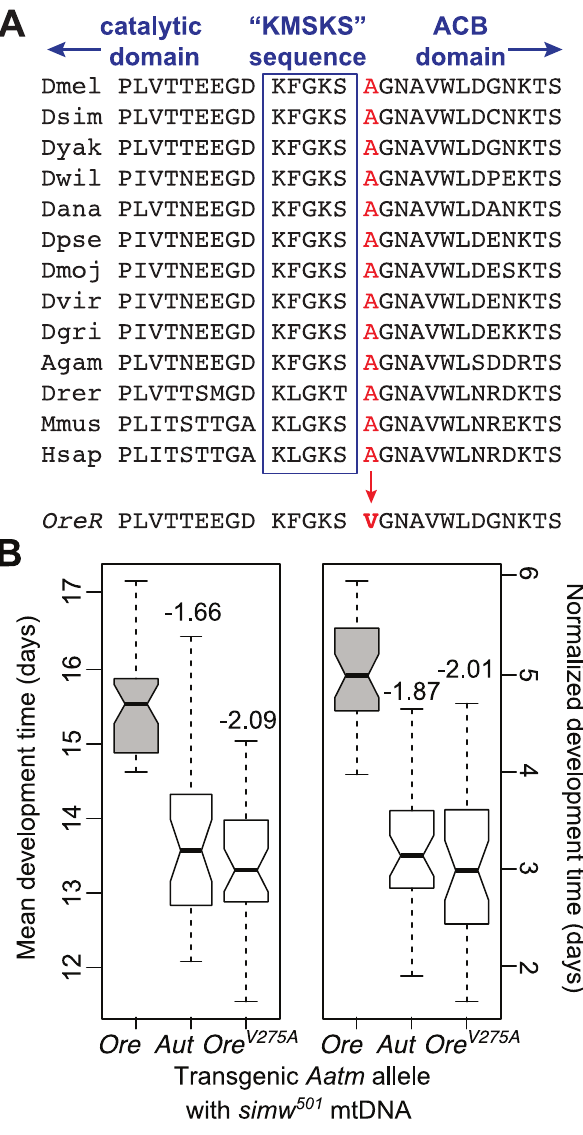
Figure 5. An amino acid change in the mt-TyrRS gene Aatm is incompatible with the mt-tRNA Tyr polymorphism. (A) A nonsy- nonymous SNP in the D. melanogaster OreR nuclear-encoded mt-TyrRS gene Aatm changes a highly conserved alanine to a valine at a residue adjacent to the class I aaRS ‘‘KMSKS’’ signature sequence located in a loop that connects the catalytic domain to the anticodon binding (ACB) domain [38]. Nine Drosophilid species sequences are followed by mosquito ( Anopheles gambiae ), zebrafish ( Danio rerio ), mouse ( Mus musculus ) and human. (B) Both the transgenic Aatm Aut allele and the Aatm Ore_V275A allele that reverts the valine in the OreR allele to the conserved alanine significantly recover development time in a simw 501 mitochondrial background and recapitulate the developmental differ- ence between the ( simw 501 ); OreR and ( simw 501 ); AutW132 genotypes. Boxplots show the distributions of mean development time for all individuals emerging from a single vial, and notches indicate the approximate 95% confidence intervals around the medians. Numbers above the boxes indicate the magnitude of the reduction in development time in days, relative to the incompatible Aatm Ore allele ( P Tukey , 0.0001, both alleles). Normalized development time is relative to control siblings that emerge from the same vial. Data were pooled across sexes, as the effects were the same in males and females (Figure S3 and Table